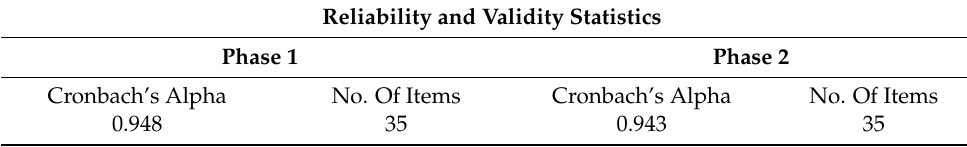
Table 4. Reliability test phase 1 (combined all variables).